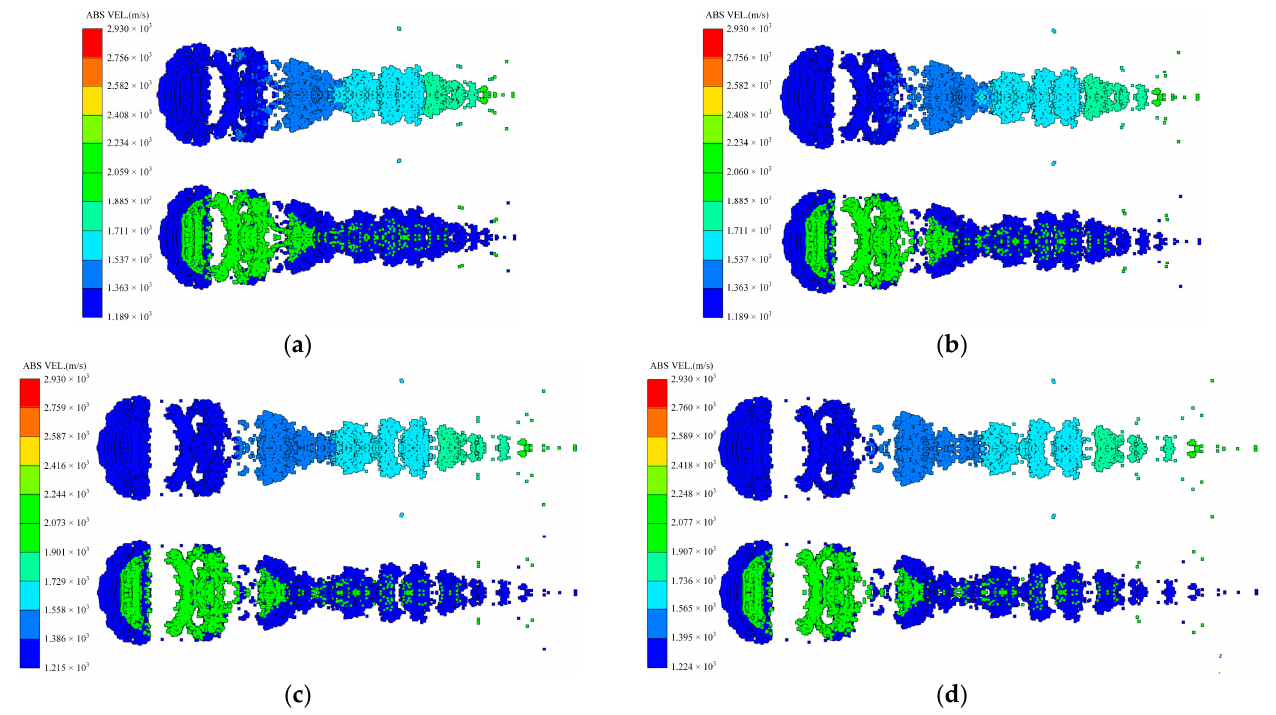
Figure 9. Stretching phase: ( a ) t = 100 μ s; ( b ) t = 115 μ s; ( c ) t = 130 μ s; ( d ) t = 145 μ s.